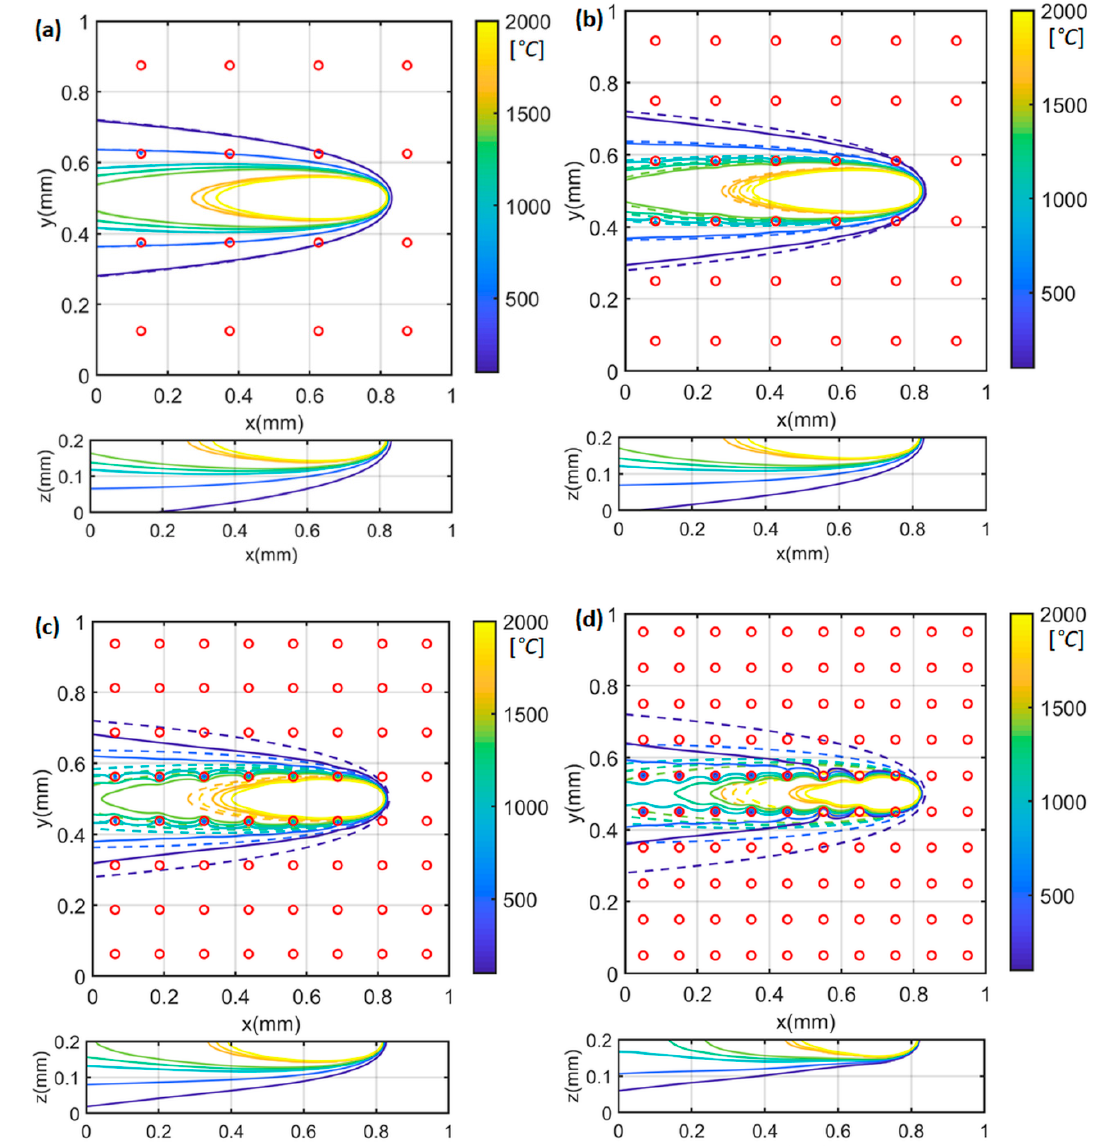
Figure 2. Calculated three-dimensional temperature distribution with ( a ) 4 × 4 = 16 heat sinks, ( b ) 6 × 6 = 36 heat sinks, ( c ) 8 × 8 = 64 heat sinks, and ( d ) 10 × 10 = 100 heat sinks. The dash lines represent the calculated temperature profiles without consideration of heat loss (zero heat sink). The solid lines represent the calculated temperature profiles with consideration of heat loss. Red circles represent the centers of heat sinks. The heat source is located at x = 0.8 mm, y = 0.5 mm.